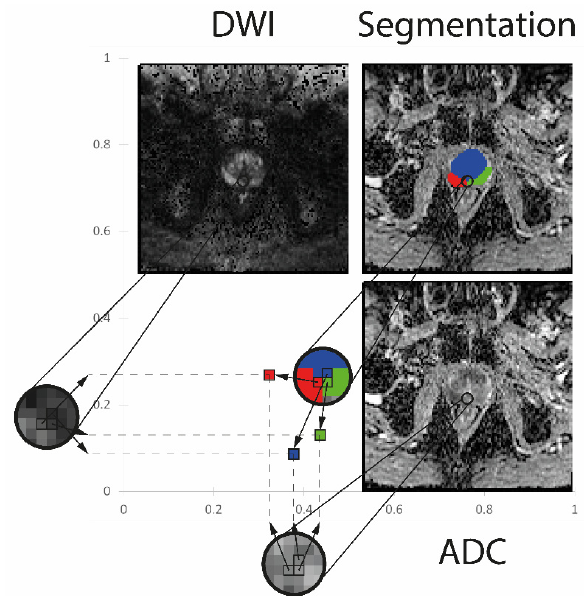
Figure 1. Creation of the 2D histograms. Every pixel in a two-dimensional (2D) histogram contains information from three different voxels. The normalized intensity of the DWI is plotted on the y - axis and the normalized ADC value on the x -axis. Furthermore, the images are segmented to enable differentiation of the underlying tissue and color-coding thereof in the final 2D histogram. For ex- ample, the tumor voxel has the coordinates (0.32, 0.27) and is colored in red. Additionally, two more voxels are plotted for the transitional zone (blue) and the peripheral zone (green). 2.6. Multichannel Computed Diffusion Images The 2D histograms of these 70 patients (training dataset) were analyzed, and the PCa and normal prostate tissue areas were defined. The size, shape, and location of these areas were used to generate rules for the creation of a so-called intensity map. These rules were translated into gradients that were plotted onto the intensity map. Those rules are ex- plained in detail in the Results. Finally, for each DWI-ADC image pair, a mcDI was gen- erated by plotting the intensity map values back onto the initial voxel locations. For ex- ample, tumor voxel A (0.3, 0.2) corresponds to an intensity of 70% gray on the intensity map. Therefore, the voxel in the mcDI will be represented by this dark color. This whole algorithm is visualized in Figure 2. Examples of different readouts are presented in Figure 3.